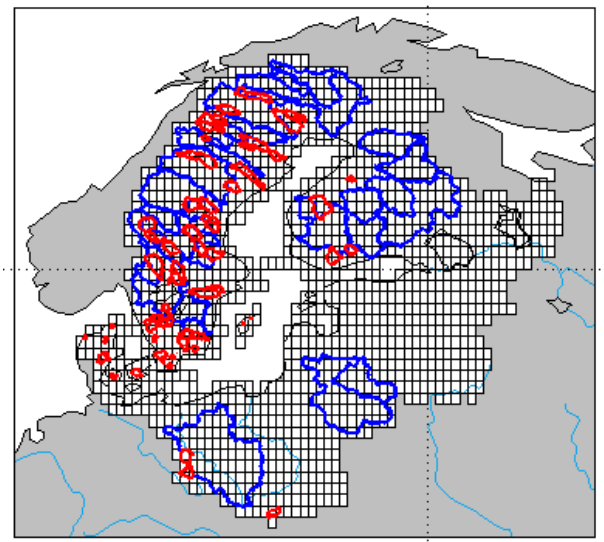
Fig. 1. Map of the Baltic Sea drainage basin as shown by 0.5 de- gree STN-30p global grid cells, with boundaries of 100 gauged sub- basins shown by lines. Source sub-basins are marked with red and Figure 1. Map of the Baltic Sea drainage basin as shown by 0.5 degree STN-30p global grid 3 the rest marked with cells, with boundaries of 100 gauged-sub-basins shown by lines. Source-sub-basins are 4 marked with red and the rest marked with blue. 5